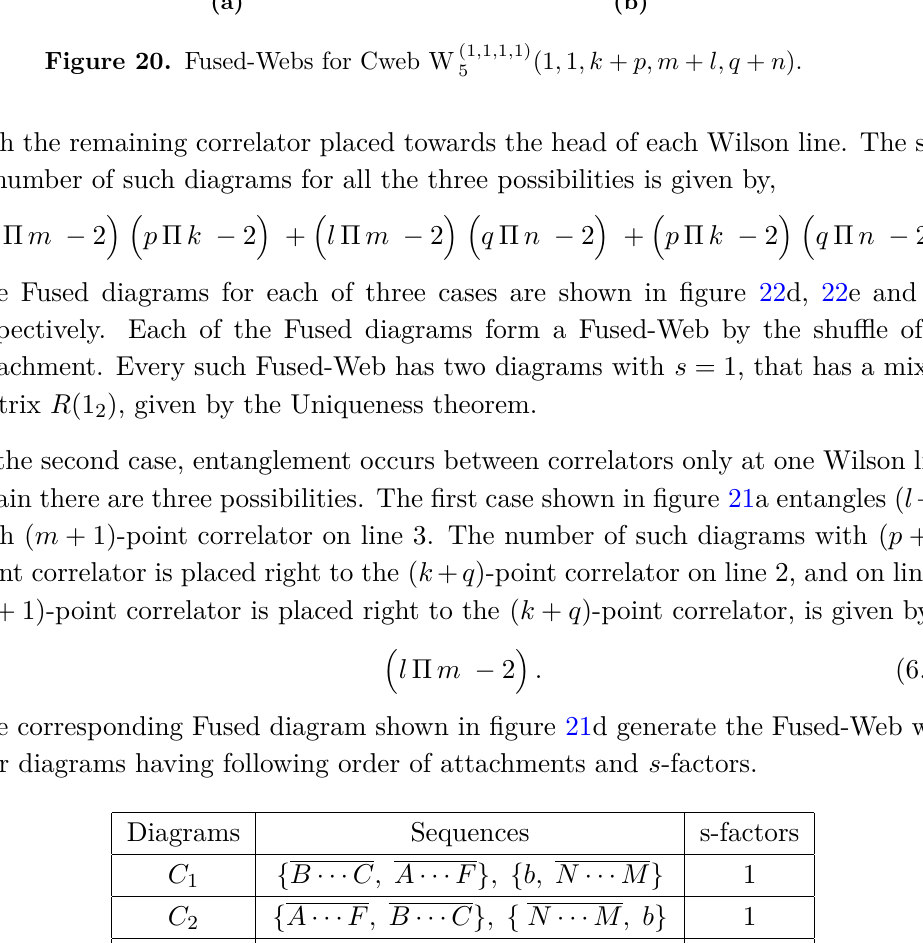
Figure 20. Fused-Webs for Cweb W (1 , 1 , 1 , 1)